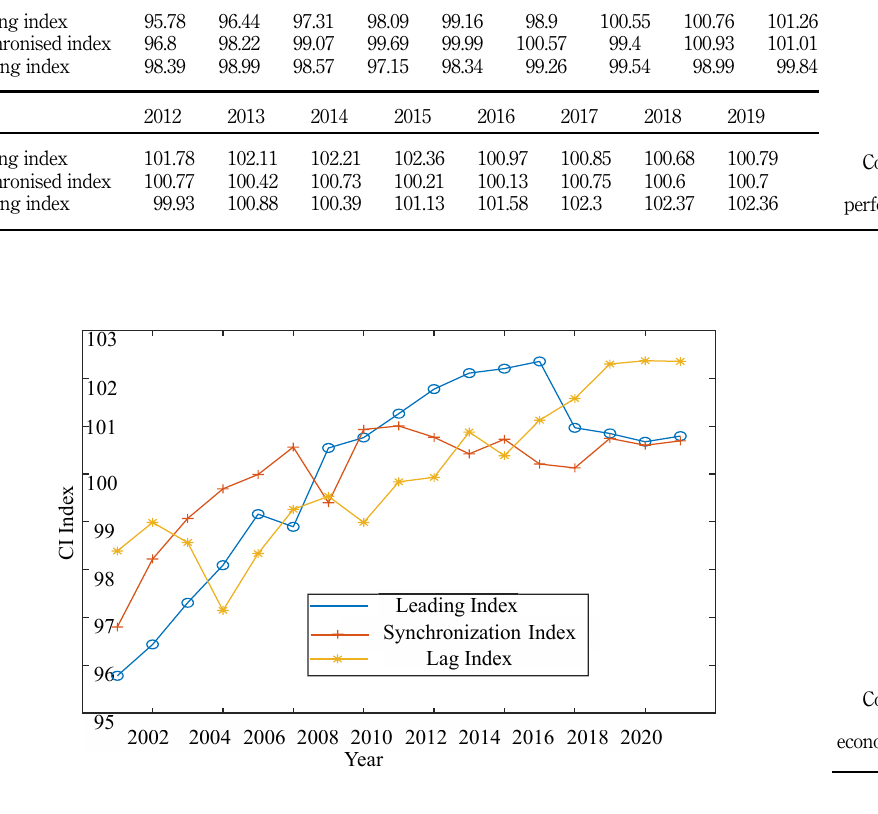
Figure 1. Composite index